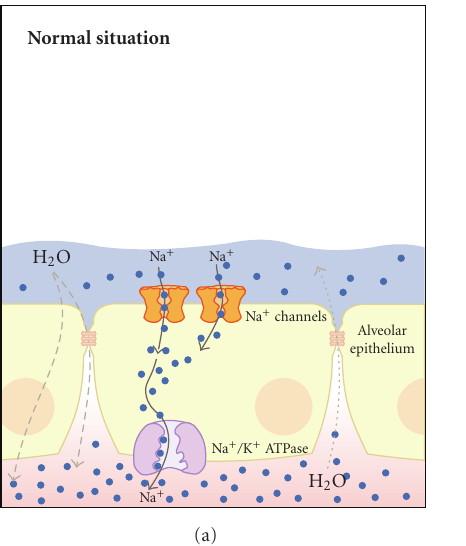
Figure 2: Impaired Na + channel activity is associated with the development of pulmonary edema. (a) under normal conditions transepithelial Na + transport mediated via Na + channels in the alveolar epithelium drives water reabsorption from the airspaces to the interstitium. This mechanism counteracts water filtration into the airspaces and keeps the fluid layer covering the alveolar epithelium low. (b) a variety of factors that inhibit Na + channels in the alveolar epithelium have been identified under diseases associated with pulmonary edema such as HAPE or ALI/ARDS: hypoxia, inflammatory mediators which are released by activated immune cells (such as macrophages or neutrophils), endothelin 1 (ET-1), reactive species such as nitric oxide (NO), or factors which are released due to hypoxia or epithelial stress such as serotonin (5-HT). The decreased activity of Na + channels leads to decreased water reabsorption and fluid accumulation in the airspaces. Under pathological conditions such as HAPE or ALI/ARDS, there is additionally increased fluid filtration into the airspaces due to impaired epithelial barrier integrity. The consequence of both impaired Na + and thus water reabsorption and increased fluid filtration is the development of pulmonary edema. The figure has been modified from [2]. For clarity, aquaporins and potassium fluxes/channels, as indicated in Figure 1, have been